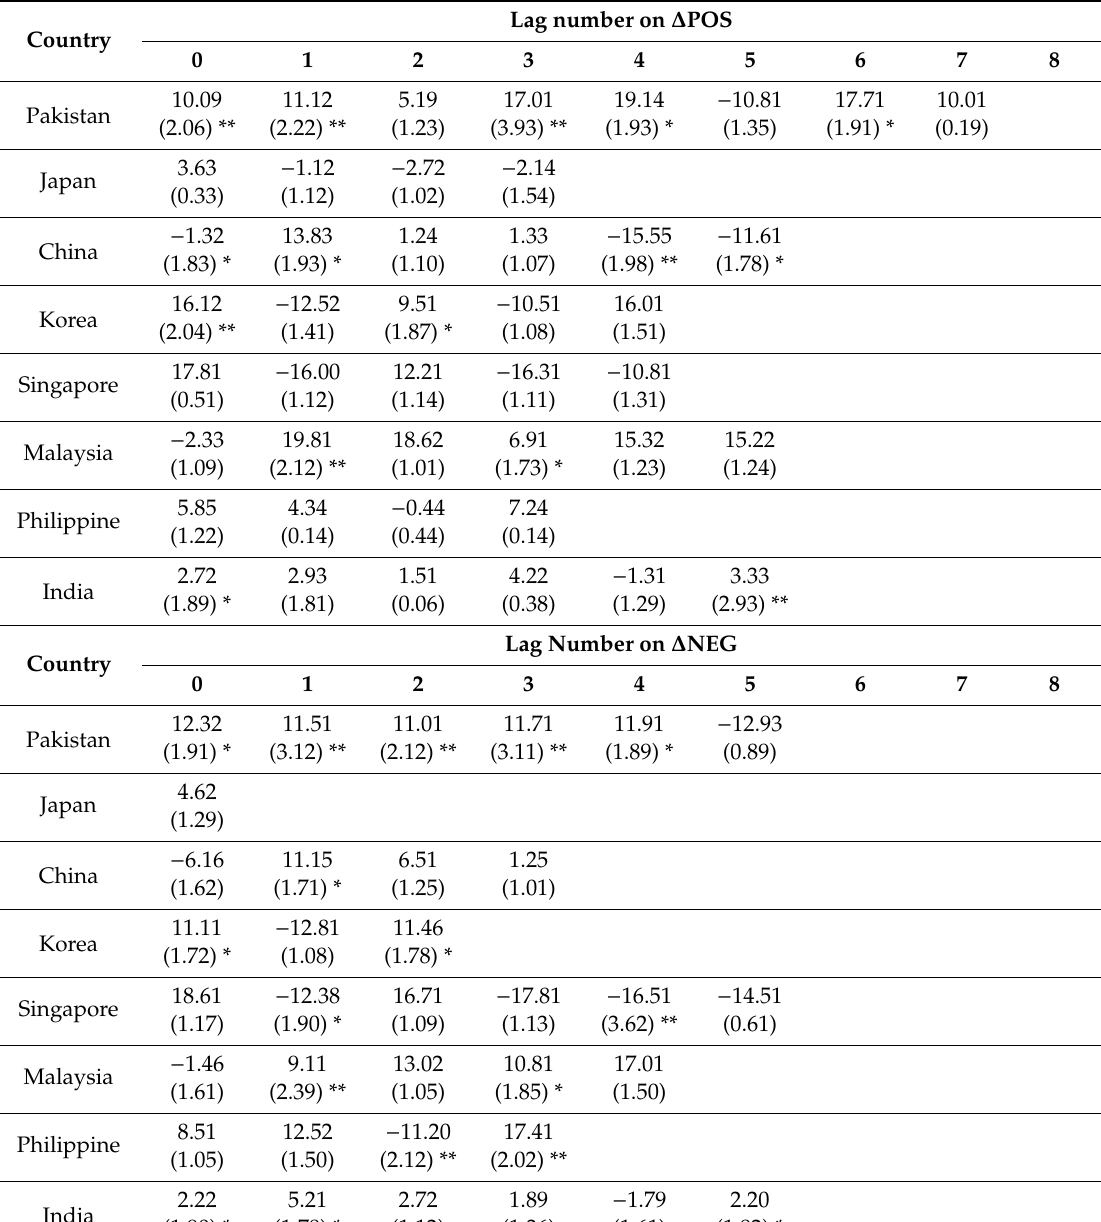
Table 7. Short-run Coe ffi cient Estimates Attached to ∆ POS and ∆ NEG in the Non-linear Import Demand